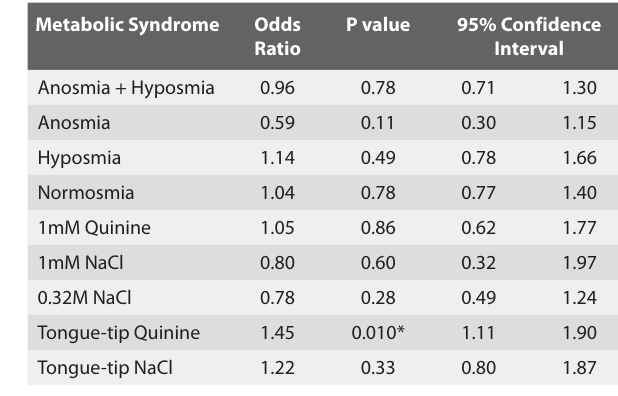
Table 2. Univariate analyses of smell and taste dysfunction versus obe- sity.